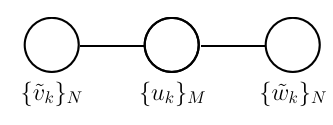
Figure 13 . so (6) Dynkin